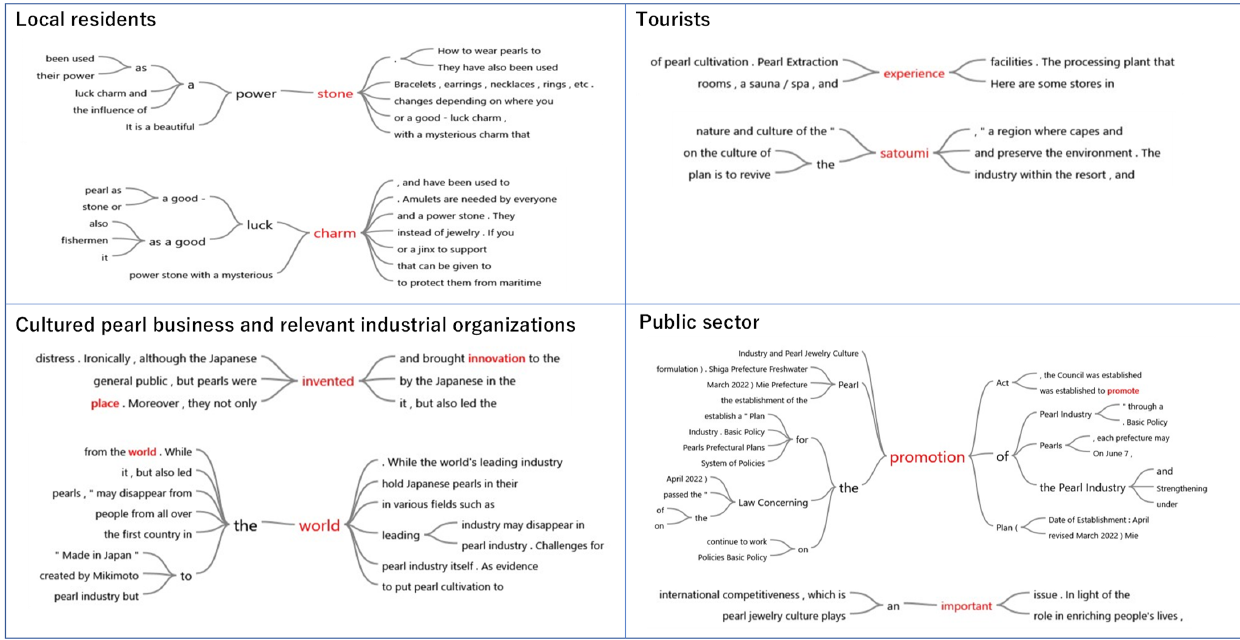
Figure 2 Word trees of four stakeholders. Figure 2. Word trees of four